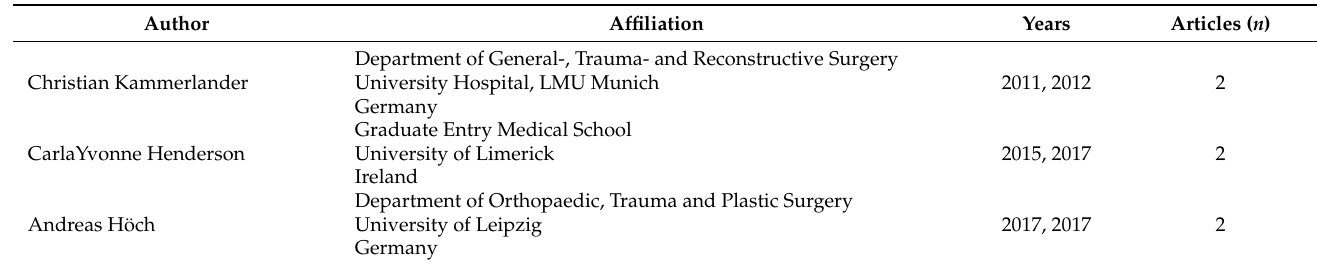
Table 2. List of authors with more than one article as first author.